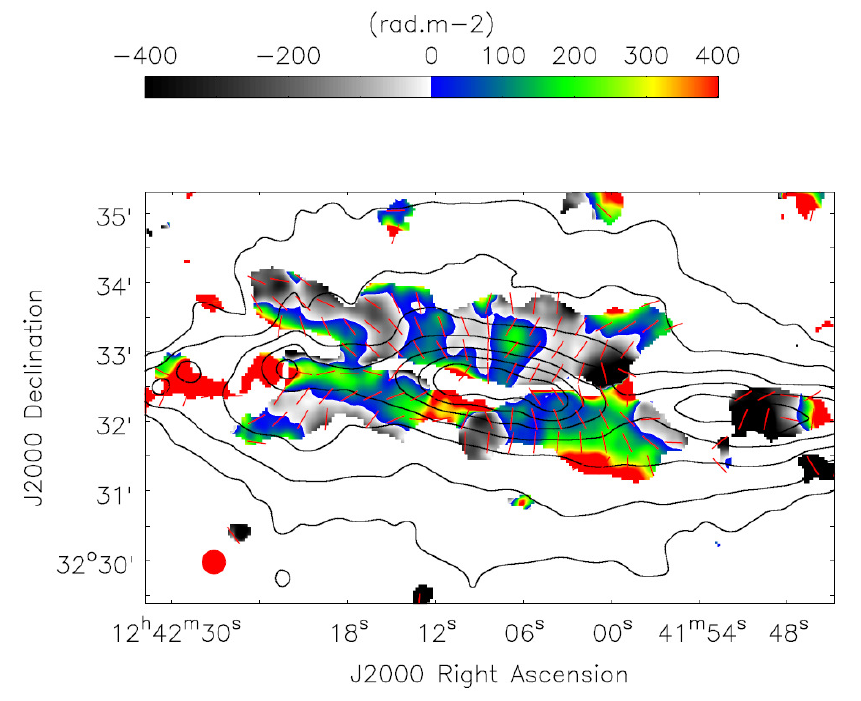
Figure 4. Total intensity emission contours over a colour image of RMs in NGC 4631 from [36]. Linear polarization vectors corrected for Faraday rotation are shown in red. Notice the east/west positive/negative RM reversals in the halo to the north of the disk. The colour scale at top specifies the RM values. The beam is shown as a red dot at the lower